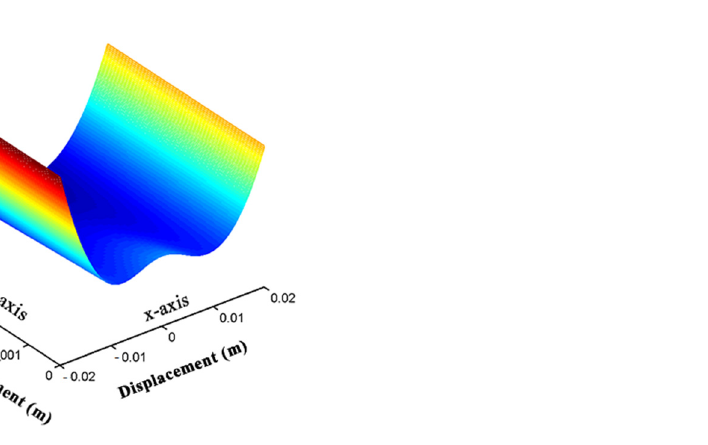
Figure 9. Phase plane portrait, Poincaré map, and output voltage histories for excitation frequency f = 4 Hz. ( a ) Phase plane portrait and Poincaré map. ( b ) Voltage histories for BPEH-V, respectively. ( c ) Phase plane portrait and Poincaré map. ( d ) Voltage histories for CBH-C, respectively. However, the CBH-C system only made a small-amplitude intrawell motion at this time, as shown in Figure 9c. Meanwhile, compared with Figure 9b,d, we found that the BPEH-V generated a much higher output voltage than the CBH-C in the low excitation frequency. With the increase in excitation frequency to 5 Hz (Figure 10 shows the simulation results for BPEH-V), the Poincaré map is concentrated in a single point and the phase plane portrait consists of a closed obit, as shown in Figure 10a, which demonstrates that the BPEH-V entered into large-amplitude periodic oscillations. However, the CBH-C system still made a small-amplitude intrawell motion at this time, as can be found from the bifurcation diagram of the tip displacement versus the excitation frequency depicted in Figure 8b.